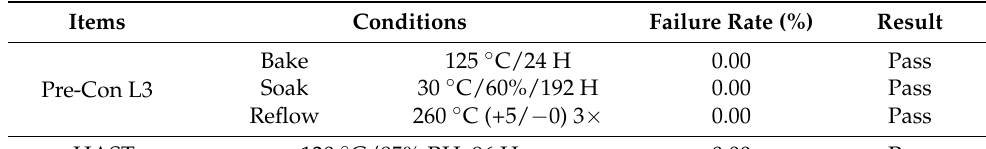
Table 3. Items and results of reliability test.